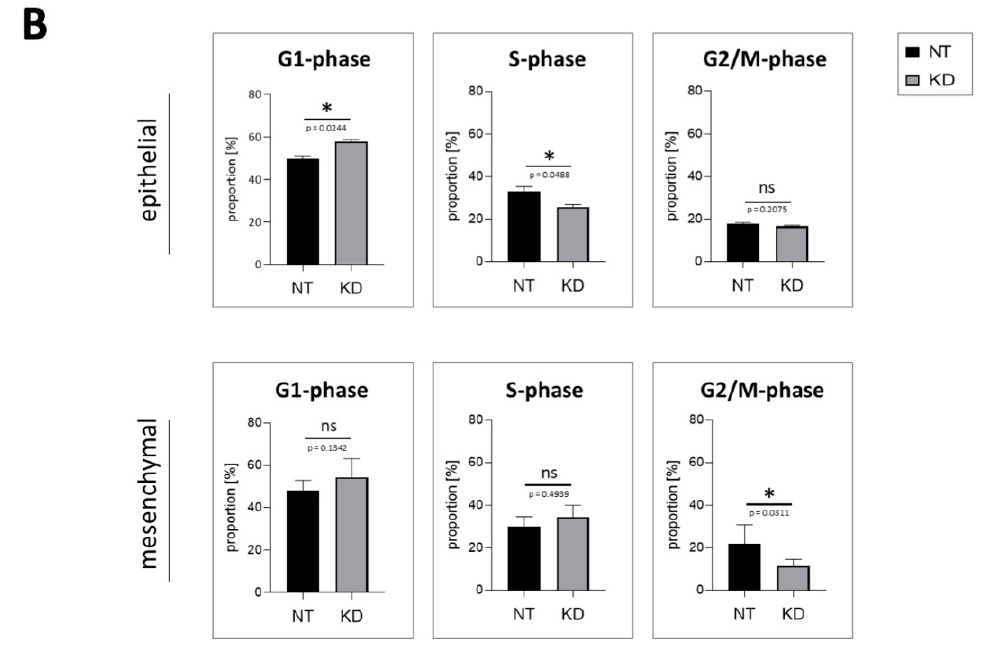
Figure 6. Proportion of specific cell cycle phases after PD-L1 knockdown. In the six different HNSCC cell lines (i.e., PCI 1, 9, 13, 8, 15, and 52), PD-L1 levels were reduced after siRNA knockdown (KD). Transfection with non-targeting siRNA (NT) served as the control. ( A ) Stacked bar charts show the percentage of cells in the G1, S, or G2/M phase. All three phases together sum up to 100%. ( B ) For statistical analysis, PD-L1 KD samples of the three epithelial and three mesenchymal cell lines were compared with their respective NT controls, using ratio paired t -tests (ns = p ≥ 0.05; * = p < 0.05). n = 3. KD efficiency is shown in Supplementary Materials Figure S3. The effect on the proliferation rate